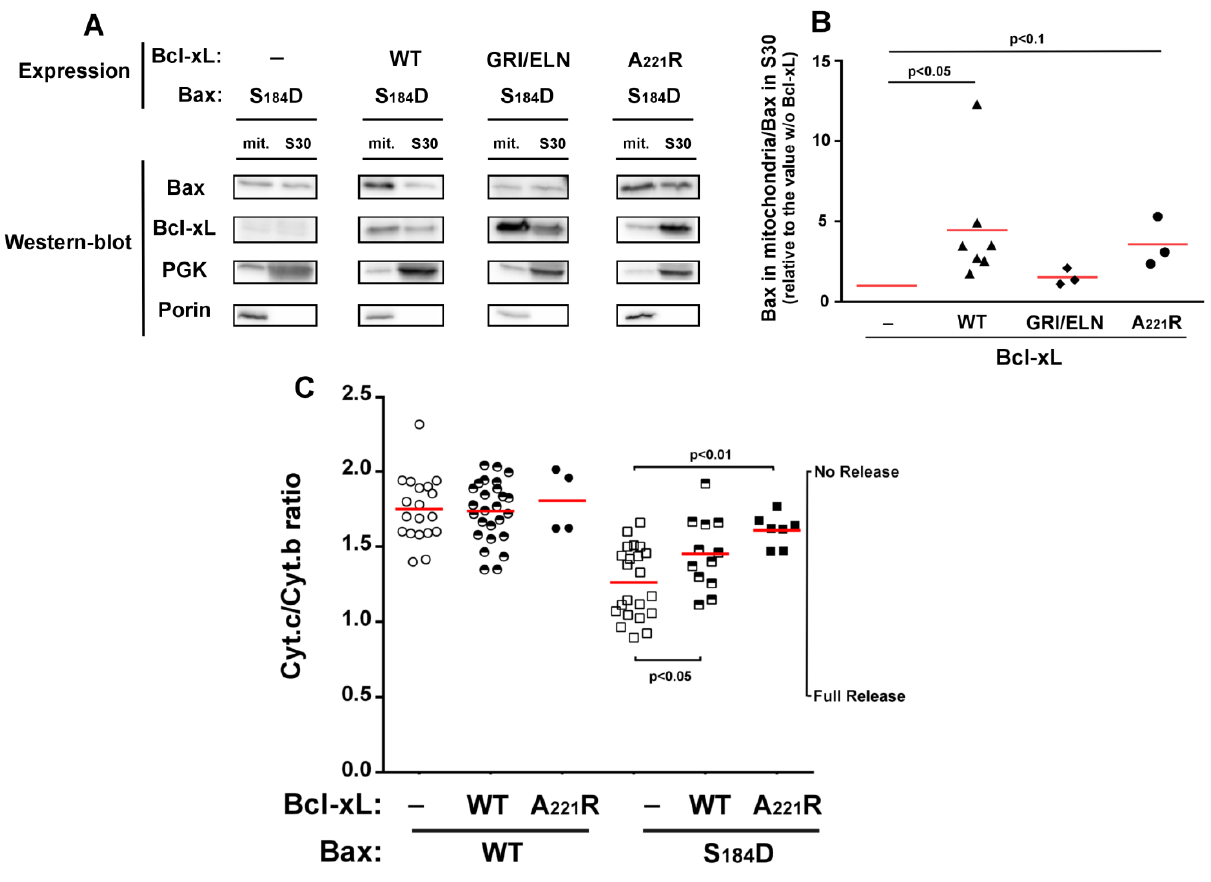
FIGURE 1: Effect of Bcl-xL on the localization and function of a Bax phosphomimetic mutant. Mitochondria (mit.) and post-mitochondrial supernatant (S30) were isolated from strains co-expressing Bax-S184D and wild-type Bcl-xL (WT), Bax interaction-deficient mutant carrying a triple mutation G138E/R139L/I140N (GRI/ELN), or a cytosolic mutant carrying a single mutation A221R (see Fig. 2). (A) Western-blot analysis of Bax and Bcl-xL localization in both fractions. (B) Quantification of the ratio between mitochondrial and non-mitochondrial Bax. All the experiments were done in parallel to a control without Bcl-xL, for which the ratio was adjusted to 1, as a reference. (C) Mitochondrial cyto- chrome c content, measured as the ratio cytochrome c /cytochrome b (unreleased cytochrome b serves as an internal control to the experi- ment). Each point represents an individual experiment. Data with wild-type Bax are given for a matter of comparison, and had been pub- lished previously [22,24,34], except for the results with wild-type Bax and Bcl-xL-A221R. Red bars indicates the averages. p values were cal- culated with an unpaired Student's OPEN ACCESS | www.microbialcell.com